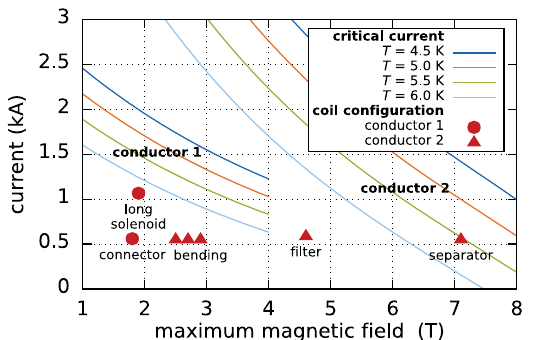
Figure 8. Critical current I c versus magnetic field B at different temperatures T , calculated according to [45] using the nominal wire specification of the two coductors used [43,47]. The markers denote the configuration of the different coils of PERC at B 1 =